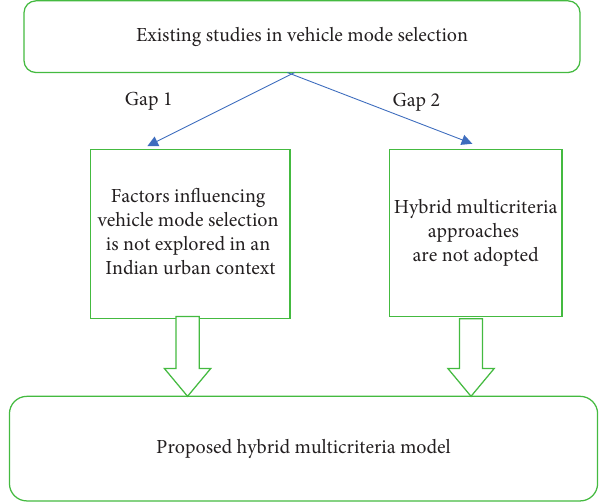
Figure 2: Research